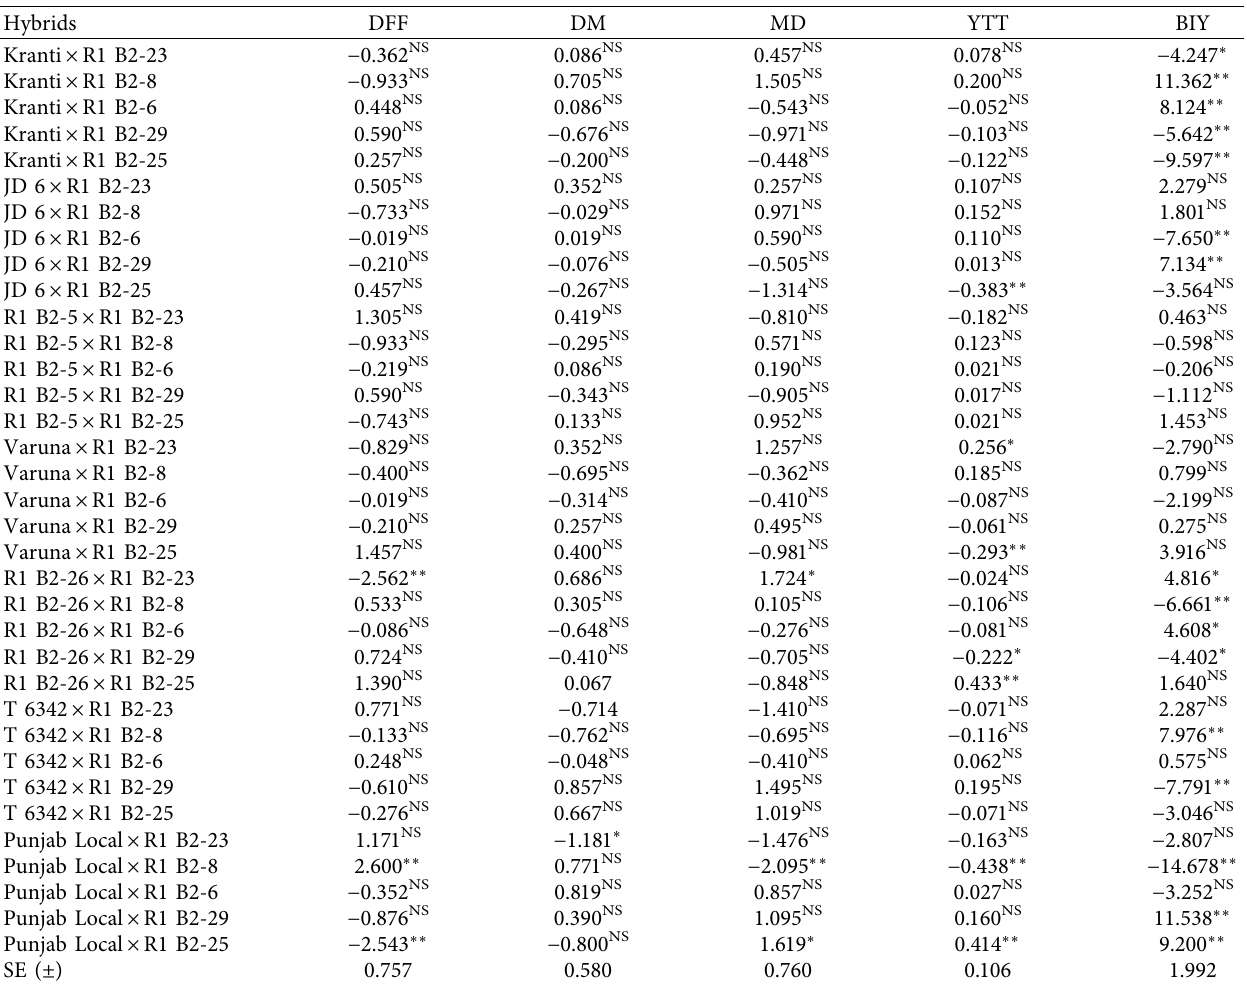
Table 10: Specific combining ability (SCA) effects of mustard hybrids on yield and its attributed